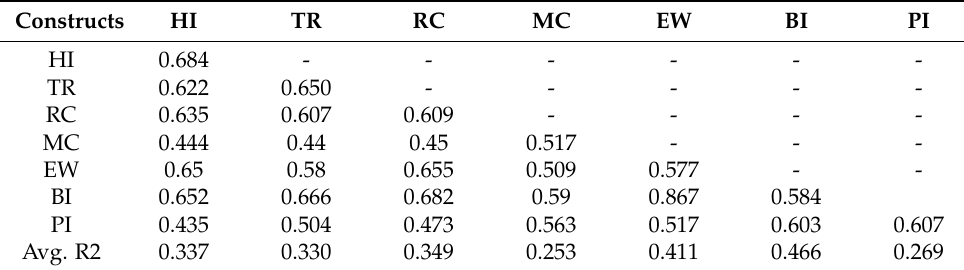
Table 3. Constructs correlation.